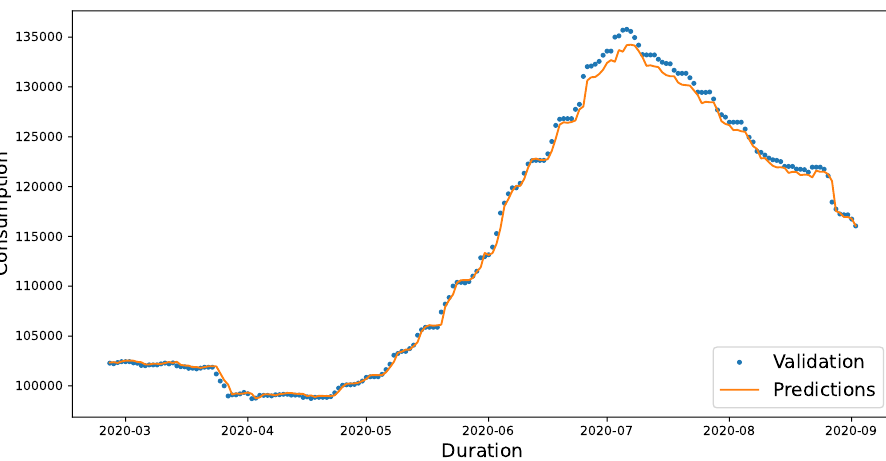
Figure 9. Deep learning model ANN loss per epochs and prediction graph: ( a ) ANN loss graph per epoch; and ( b ) water consumption prediction.